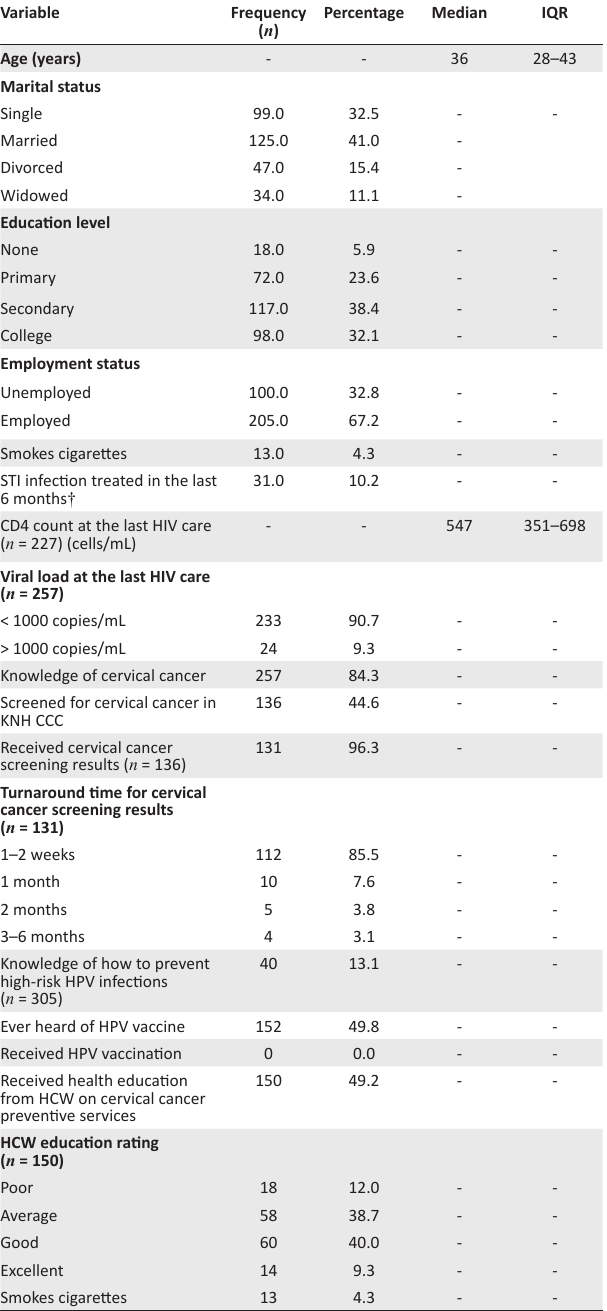
TABLE 1 : Participant characteristics, awareness, and utilisation of cervical cancer services.